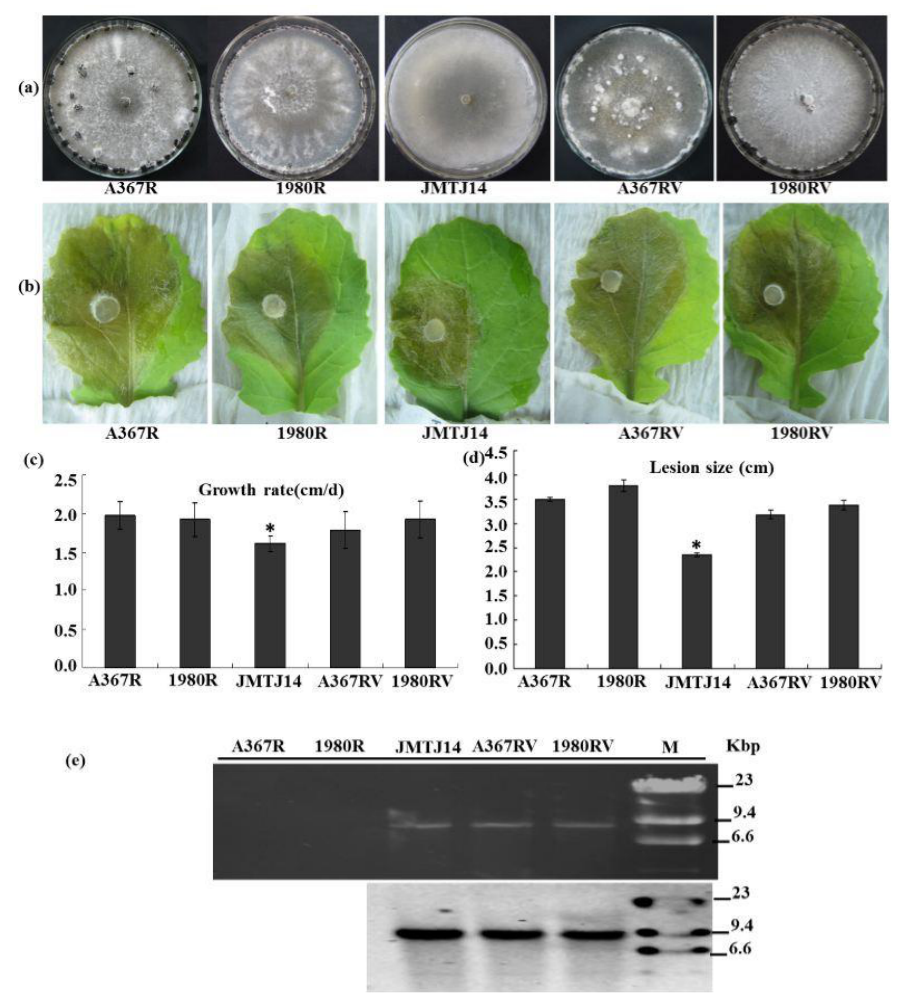
Figure 4. Biological properties of SsFV1-infected strains of S. sclerotiorum . ( a ) Colony morphology of S. sclerotiorum strains JMTJ14, A367R (EP-1PNA367R), 1980R, and two new representative SsFV1-infected strains A367RV (EP-1PNA367RV), 1980RV. All S.